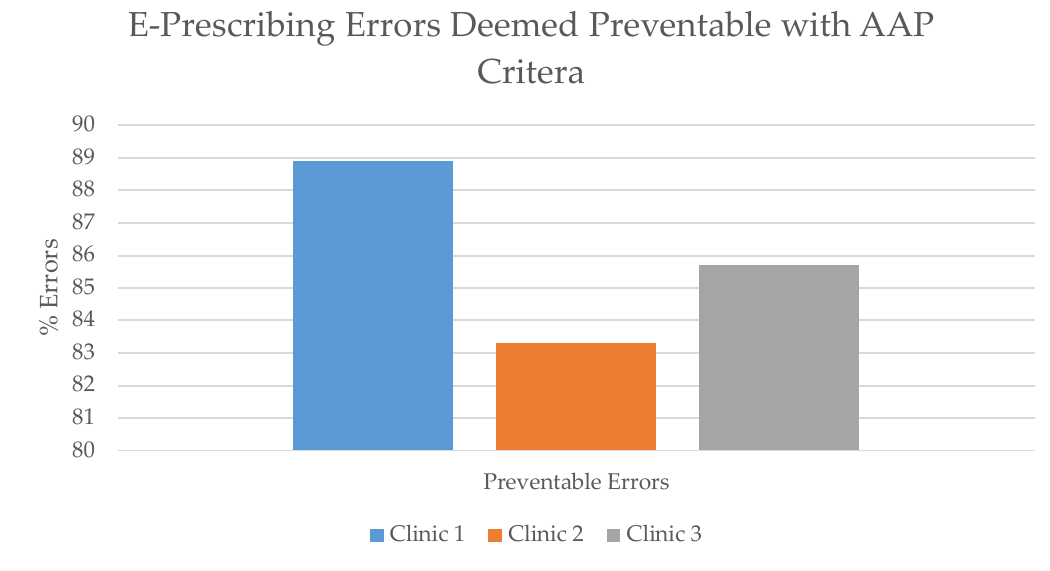
Figure 5. E-prescribing errors deemed preventable with AAP criteria.